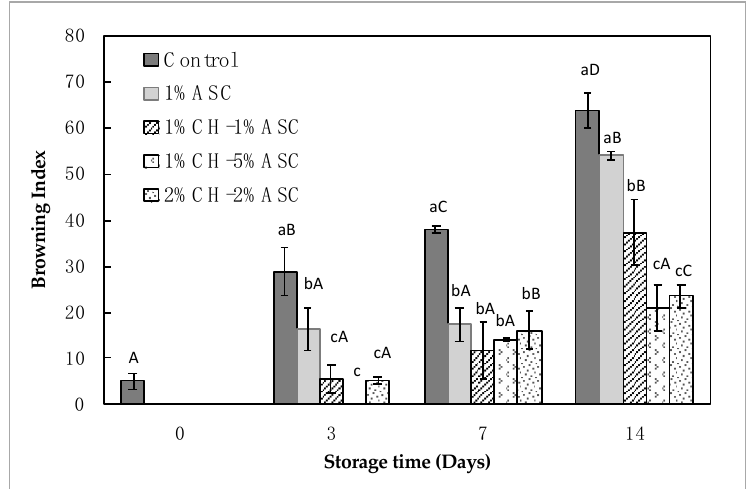
Figure 1. Changes in the browning index (%) values of fresh cut apple samples during storage at 5 ° C. Values are means of two replications. Vertical bars represent standard deviation. Data in the same day with each treatment having different superscript lowercase letters are significantly different ( p < 0.05). Data on each day of storage in the same treatment having different superscript uppercase letters are significantly different ( p < 0.05).